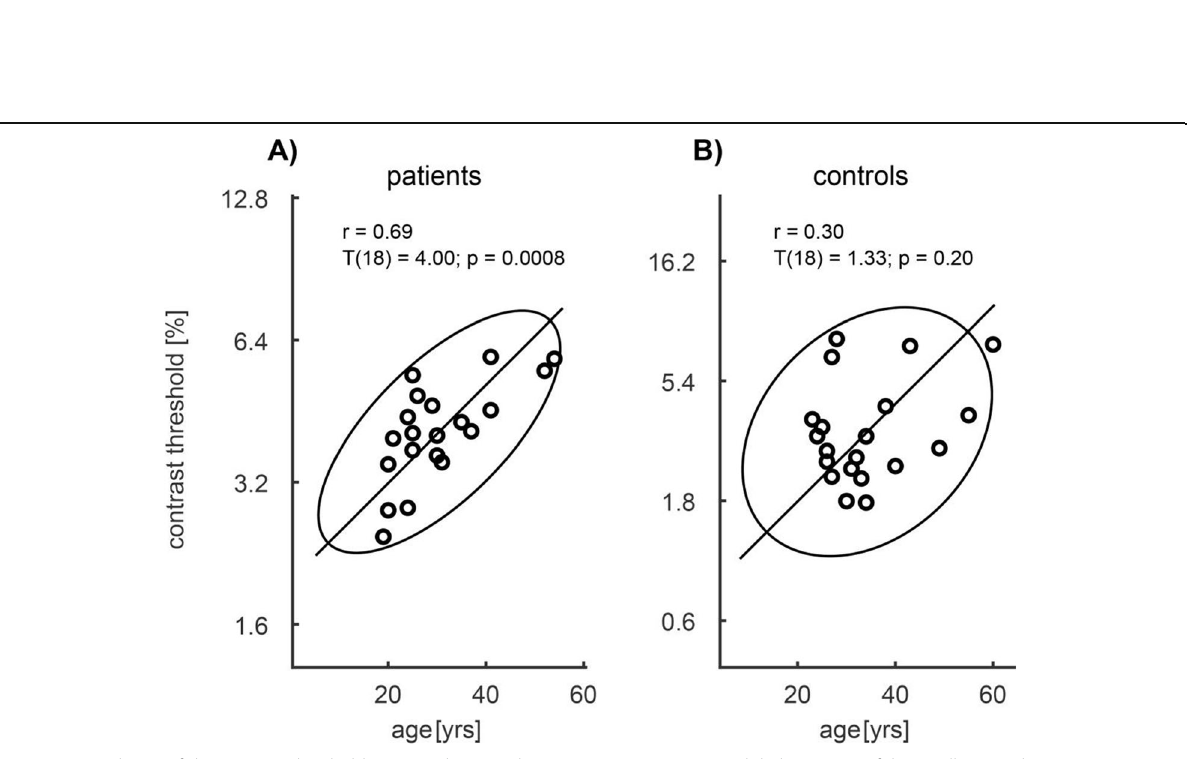
Fig. 3 Dependence of the contrast threshold in controls ( A ) and VSS patients ( B ) on age. Solid: the 95% confidence ellipse and its great semi axis. r: Pearson ’ s coefficient of correlation between age and contrast threshold. Significant correlation was observed in patients ( p < 0.001) but not in